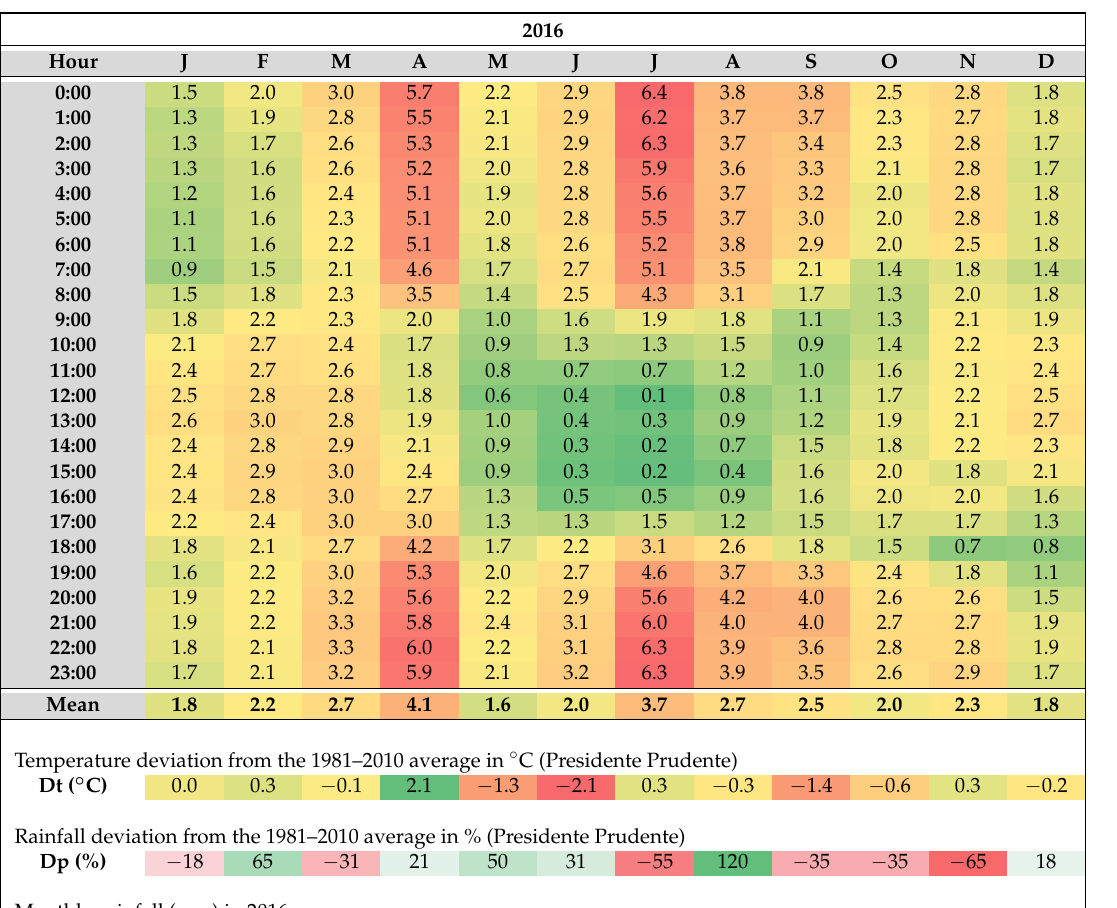
Table 3. Presidente Prudente, urban heat island: hourly average intensity, January to December 2016: temperature difference between the urban and rural